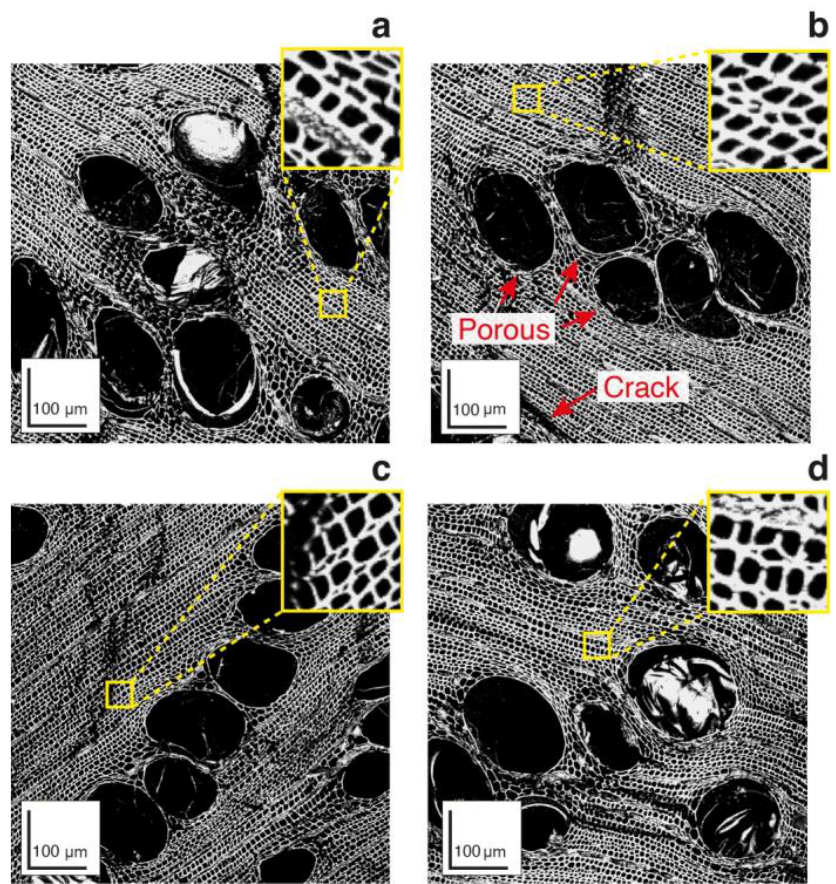
Figure 3. Confocal microscopy of the anatomical transverse structure of charcoal produced at 400 °C ( a , b ), 600 °C ( c ), and 800 °C ( d ).